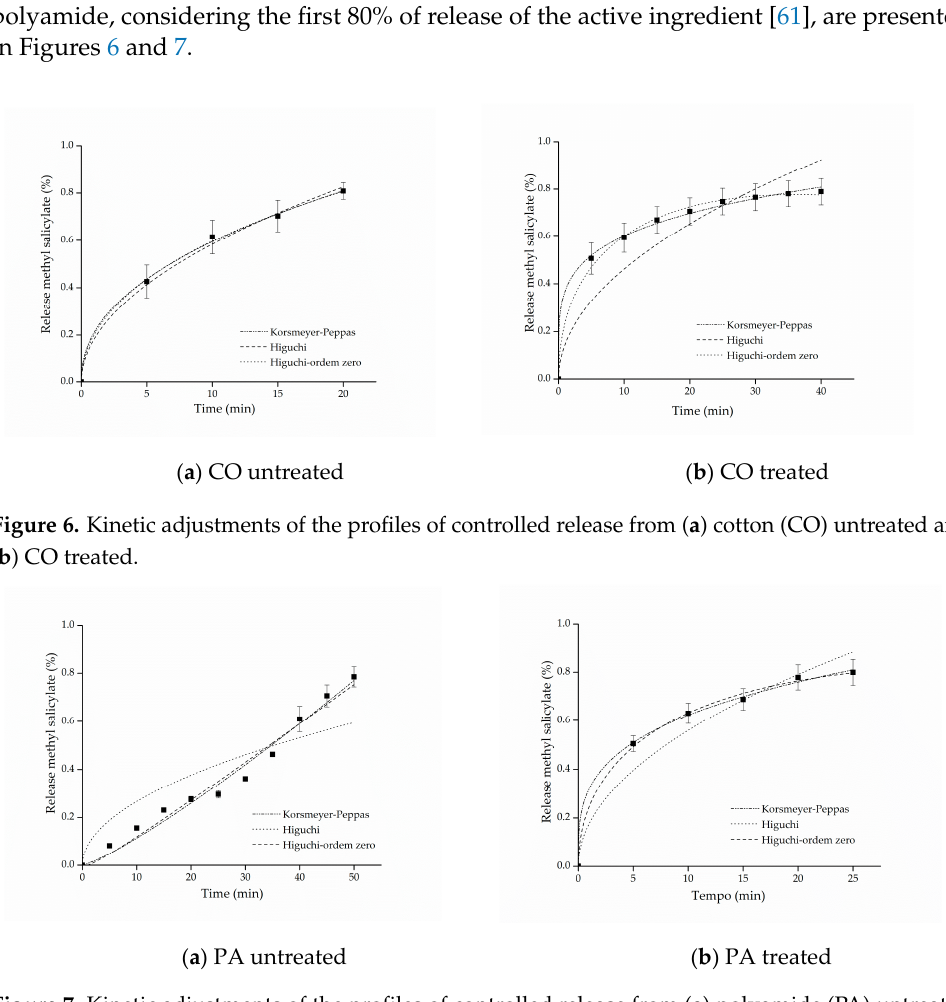
Figure 5. In vitro release profile of methyl salicylate from ( a ) cotton and ( b ) polyamide textile.